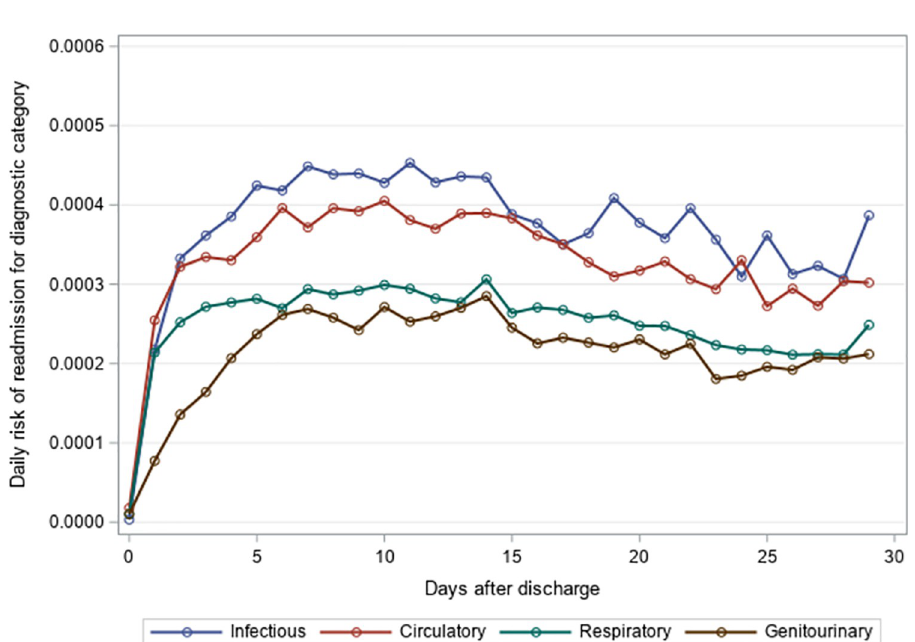
Fig 6. Daily risk of 30-day unplanned hospital readmission among older adults discharged to skilled nursing facilities following an index hospitalization for sepsis, 2014–2015. Presents the daily risk of unplanned hospital readmission for four common causes of readmission (infectious, respiratory, circulatory, genitourinary). Each year started on the Sunday of Morbidity and Mortality Weekly Report week 27 and ended on the Saturday of Morbidity and Mortality Weekly Report week 26 of the following